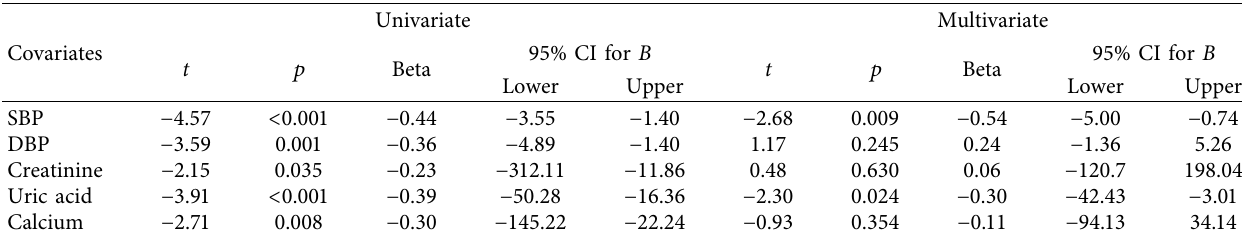
Table 3: Linear regression for serum calprotectin in the study